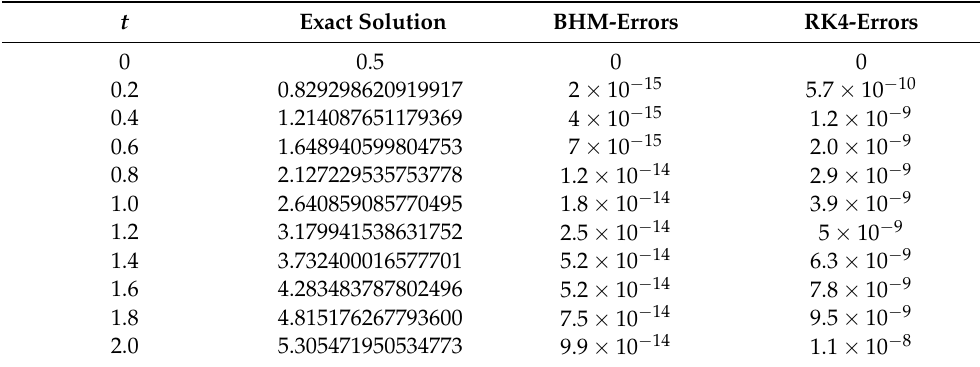
Table 1. Maximum Errors for HBM (with h = 0.2) and RK4 (with h = 0.02). t Exact